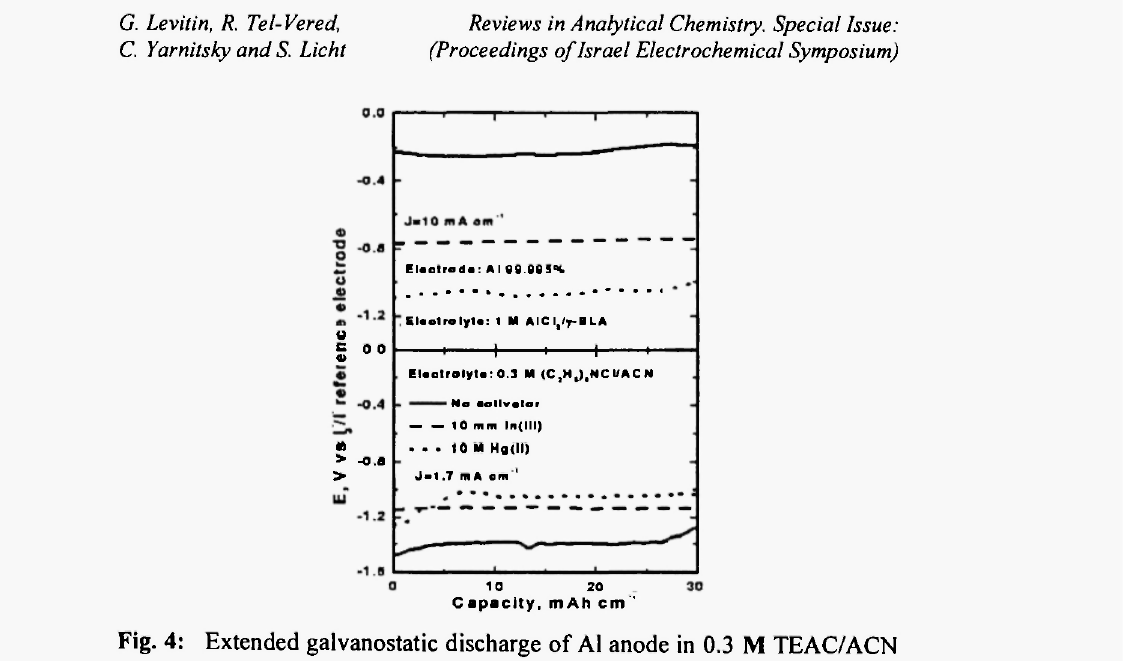
Fig. 4: Extended galvanostatic discharge of Al anode in 0.3 Μ TEAC/ACN and l Μ AlCl 3 /BLA with and without 10 mM Hg(II) or